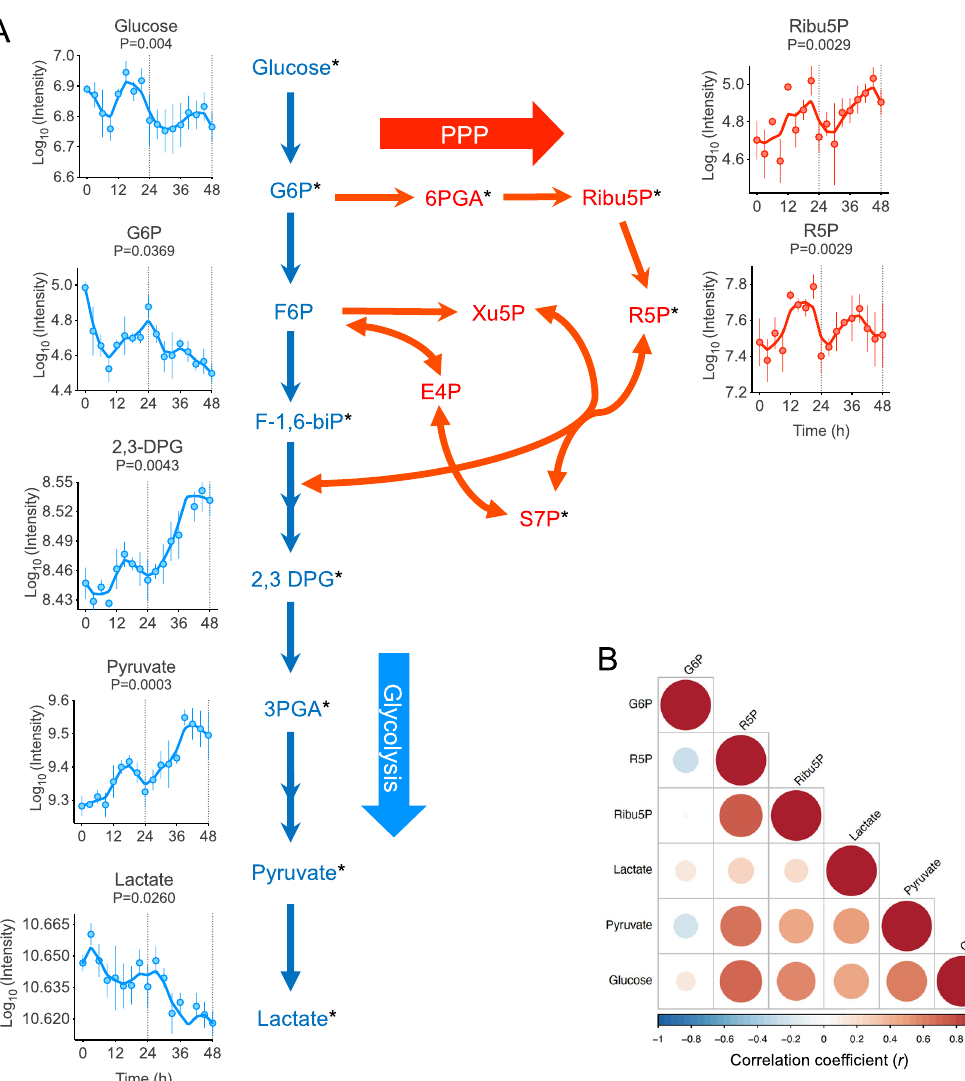
Fig. 2 Rhythmic accumulation of central carbon metabolites in human red blood cells (RBCs). A Selected signi fi cant rhythmic metabolites (* P < 0.05) in human RBCs analyzed by an untargeted metabolomics approach using GC-MS and LC-MS platforms. Rhythmicity analysis was performed using RAIN algorithm (* P < 0.05, FDR = 0.2). RBCs were synchronized for 24 h and then sampling was performed for every 3 h over a period of 48 h. Relative log10 normalized intensities for metabolites are presented. Glycolytic metabolites are represented in blue and PPP metabolites in red. List of identi fi ed rhythmic metabolites presented in Supplementary Table 1. Glucose ( n = 3 replicates), G6P = glucose-6-phosphate ( n = 4 replicates), 2,3-DPG = 2,3- diphosphoglycerate ( n = 3 replicates), Ribu5P = ribulose-5-phosphate ( n = 4 replicates), R5P = ribose-5-phosphate ( n = 3 replicates), pyruvate ( n = 3 replicates), lactate ( n = 3 replicates). B Correlation plot comparing selected glycolytic and PPP metabolites. Data are mean ±